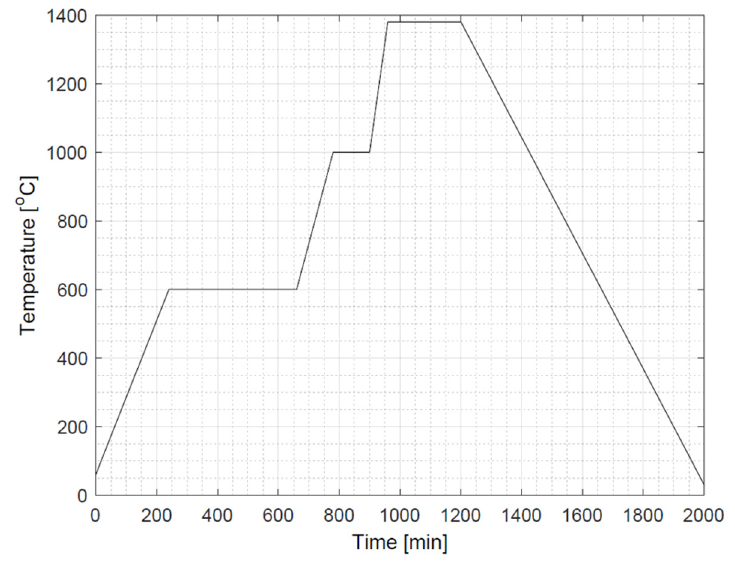
Figure 4. Applied temperature profile for sintering of 316L SS green parts printed by binder jetting.